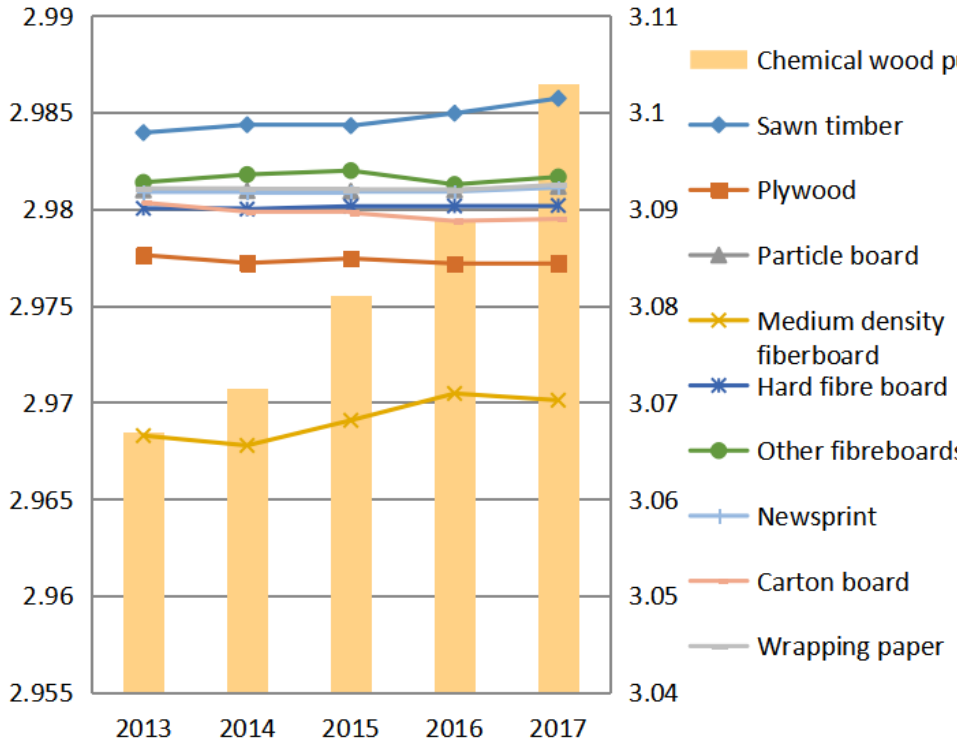
Figure 6. Comprehensive scores of entropy weight method.